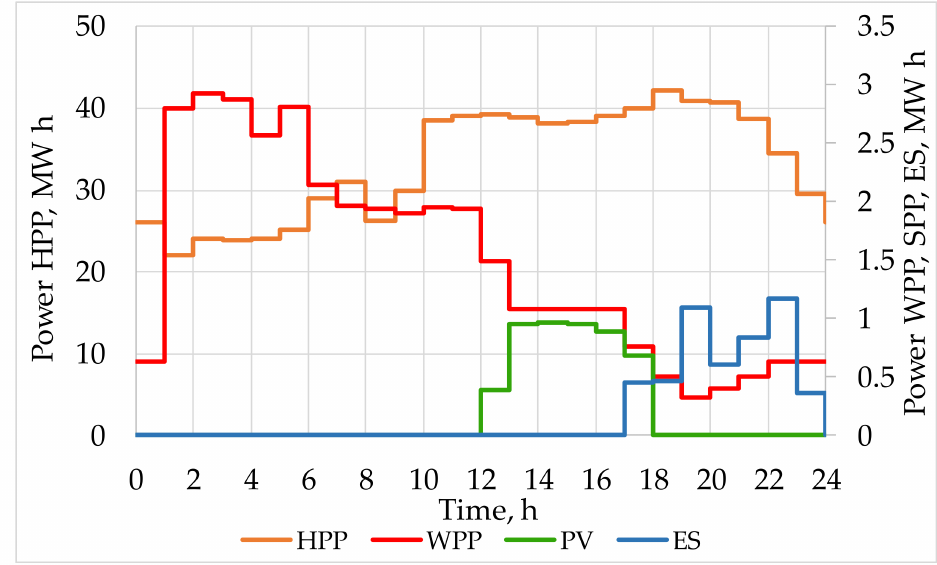
Figure 8. Selection of generating sources and energy storage devices to minimize the financial costs of electricity consumption. During this study, the most economical and efficient way of renewable and alternative energy sources joint functioning has been identified as part of the hybrid EPS aimed to achieve minimal financial costs and increase energy efficiency during such